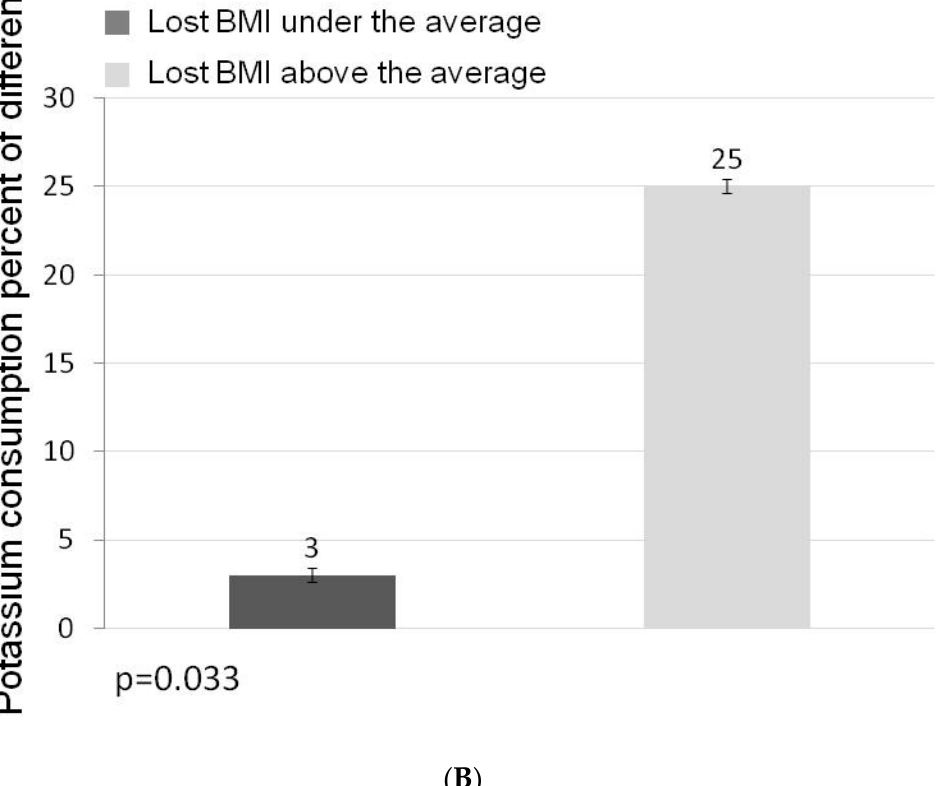
Figure 2. ( A ) Comparison of the reduction in BMI (%) achieved by subjects who increased, vs. those who decreased potassium intake ( n = 37; 27 respectively). As shown, patients who increased potassium consumption achieved a BMI reduction of 11 ± 0.8%, whereas those who decreased potassium consumption achieved a mean BMI reduction of 8 ± 0.6% ( p < 0.018). ( B ) The percent change in potassium intake, stratified by BMI loss above or below the average (9.4%). The subgroup showing above the average reduction in BMI ( n = 29) increased their potassium intake by 25 ± 0.4%, as compared to an increase in potassium consumption of only 3 ± 0.4% in subjects whose achieved reduction in BMI was below the average ( n = 35; p = 0.033).